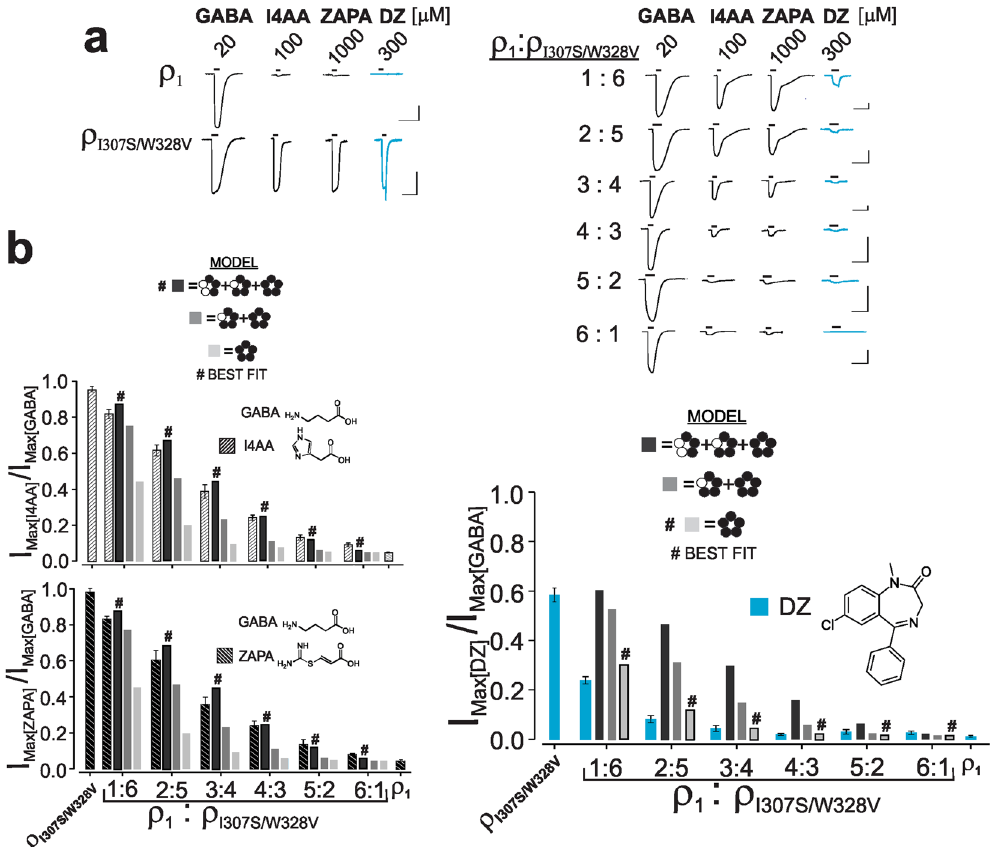
Figure 4. Variable co-expression of the ρ 1 and 307/328 mutants demonstrates a distinct activation paradigm for GABA versus diazepam. ( a ) Current traces represent the maxima of GABA, I4AA, ZAPA, and diazepam (DZ) in ρ 1 , ρ I307S/W328V , and different ratios of ρ 1 : ρ I307S/W328V . The lines above the current traces represent the duration of the drug application. The vertical and horizontal bar scales represent 100 nA and 100 seconds, respectively. ( b ) The current maxima of I4AA, ZAPA, and DZ relative to that of GABA in ρ 1 , ρ I307S/W328V , and different ratios of ρ 1 : ρ I307S/W328V . The three simulated models are shown in three shades of grey. The model representing the best fit is denoted by a hash # on the